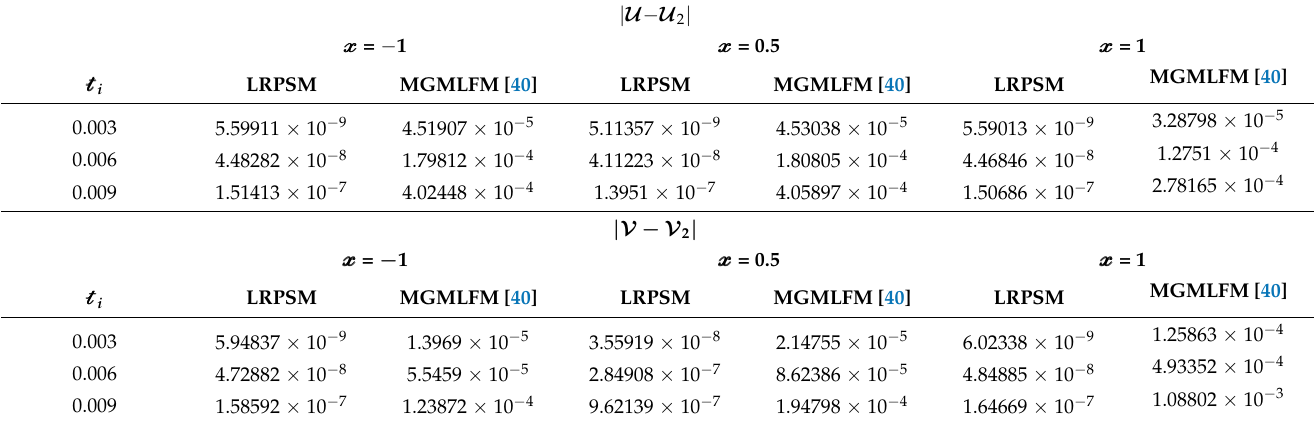
Table 7. Numerical comparisons for Example 1 at 𝒶 = 1 and different values of 𝓍 and 𝓉